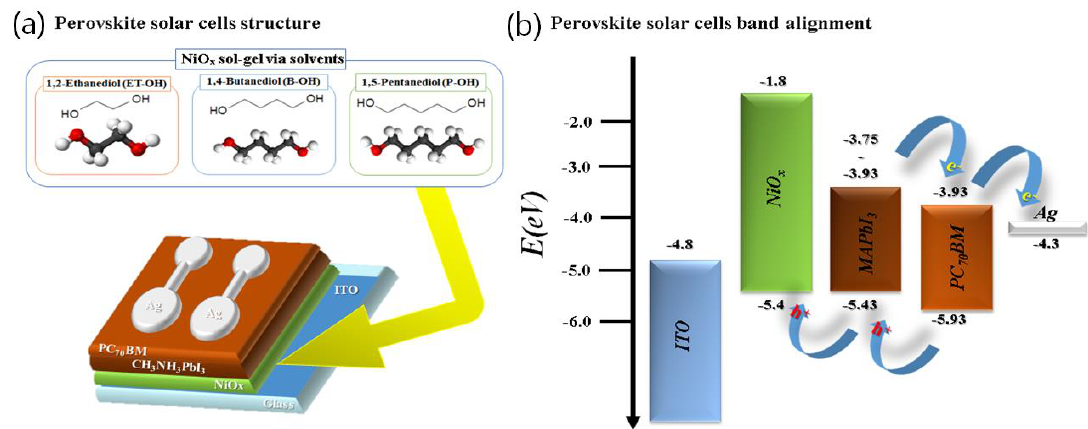
Figure 1. ( a ) A schematic diagram of an inverted planar perovskite solar cell using a hole transport layer with a NiO x thin film via solvent. ( b ) Band energy alignment of the device.